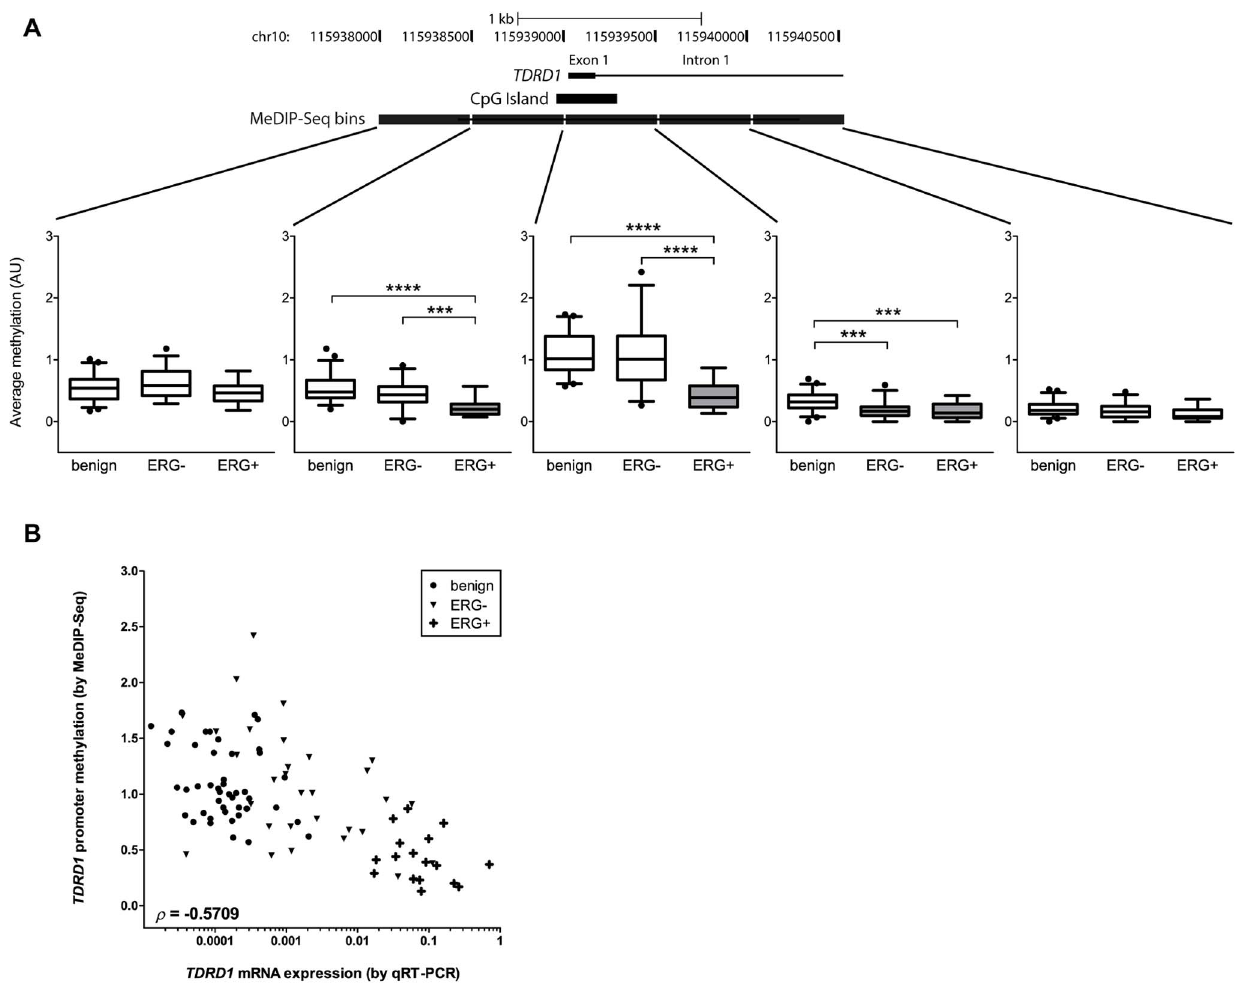
Figure 3. TDRD1 promoter associated CpG island is hypomethylated in TMPRSS2:ERG -positive prostate cancer. (A) Analysis of TDRD1 promoter methylation in prostate tumors by MeDIP-Seq. The values represent the average degree of DNA methylation of the 500-bp bins. (B) Correlation analysis of TDRD1 promoter methylation and TDRD1 mRNA expression in prostate cancer. The Spearman correlation coefficient is shown.